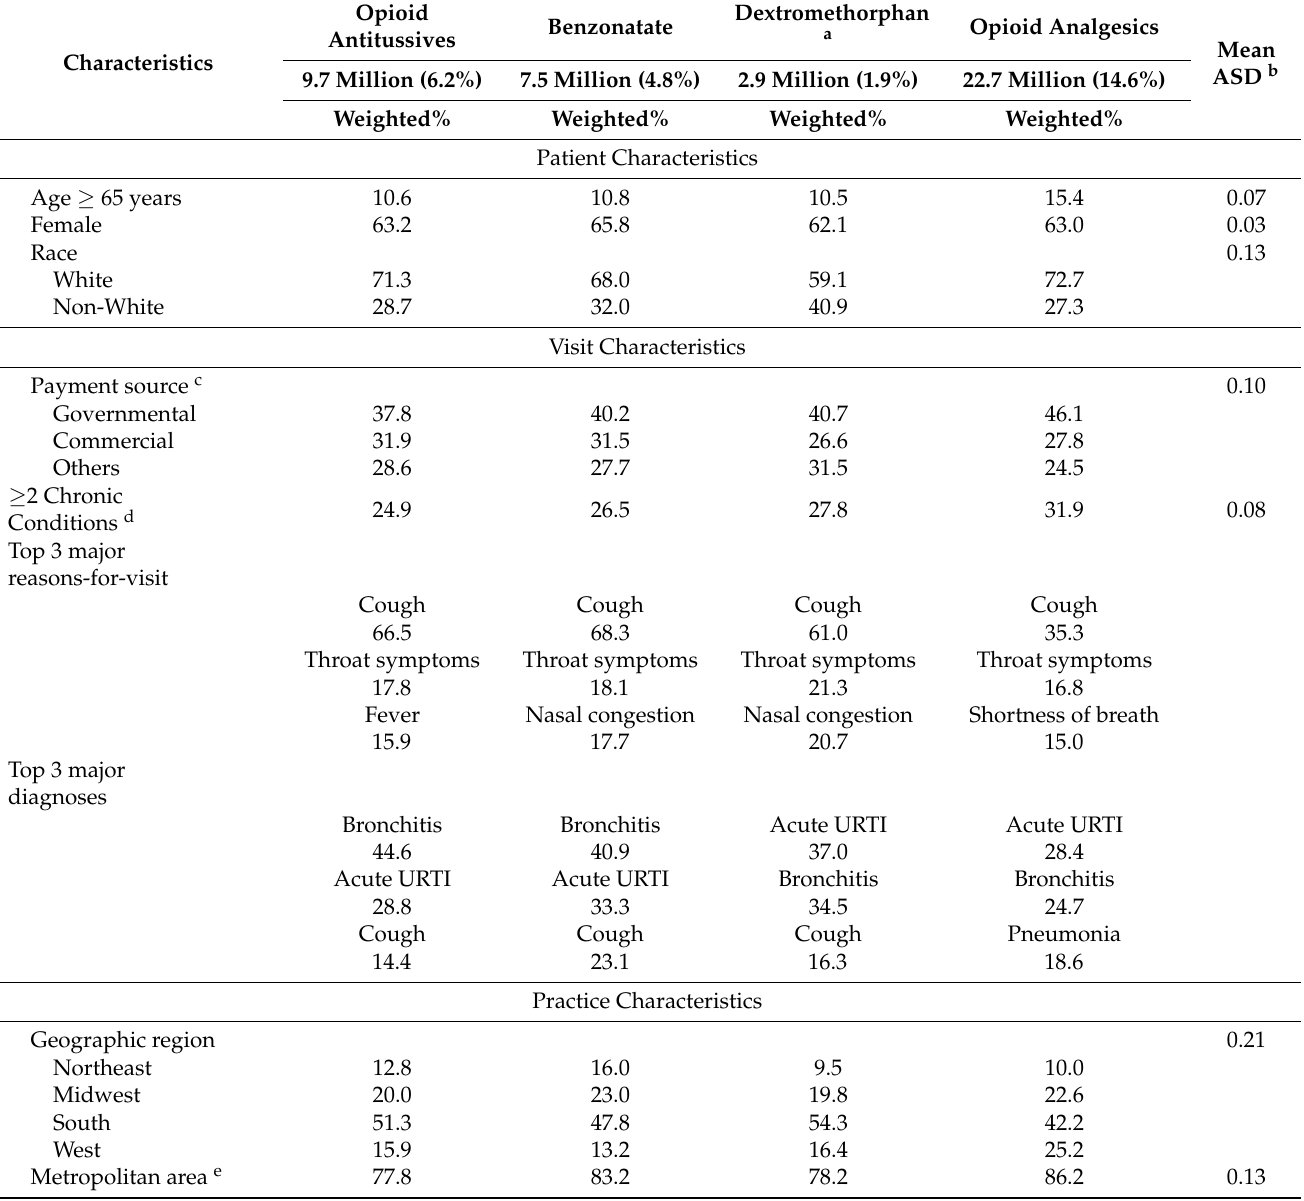
Table 2. Patient, visit, and practice characteristics of adult cough-related ED visits by medication type: 2003–2018 NHAMCS (weighted-estimate of 155.5